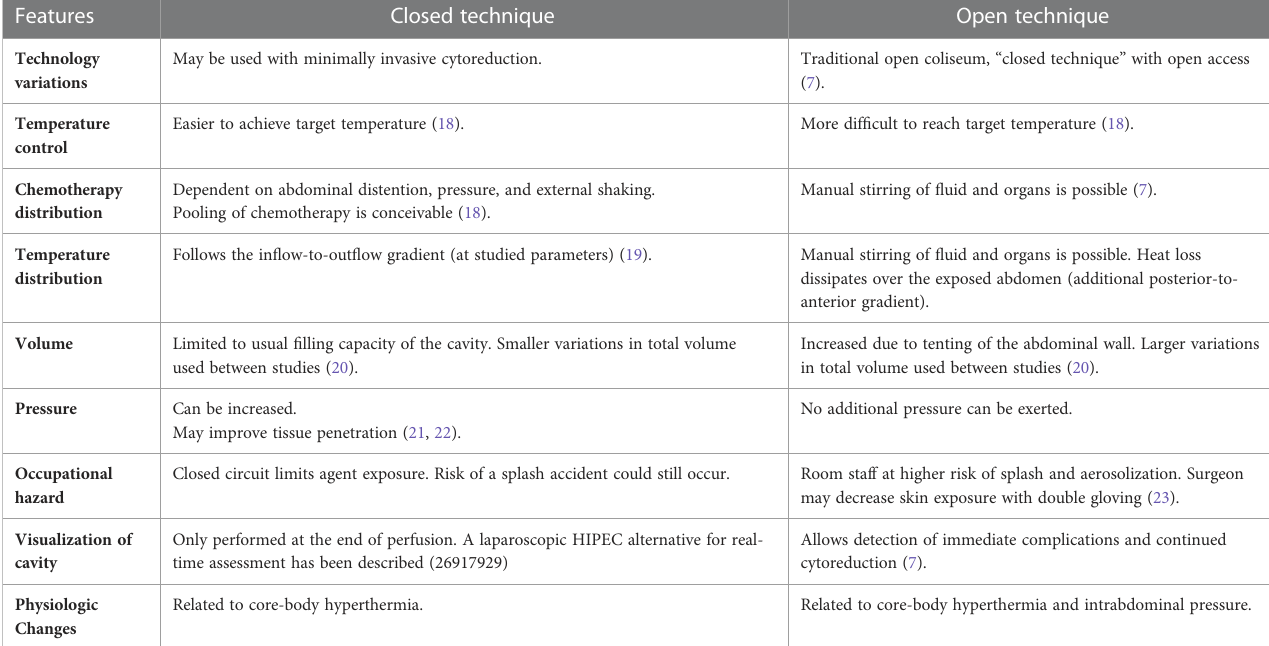
TABLE 1 Comparison of open and closed HIPEC